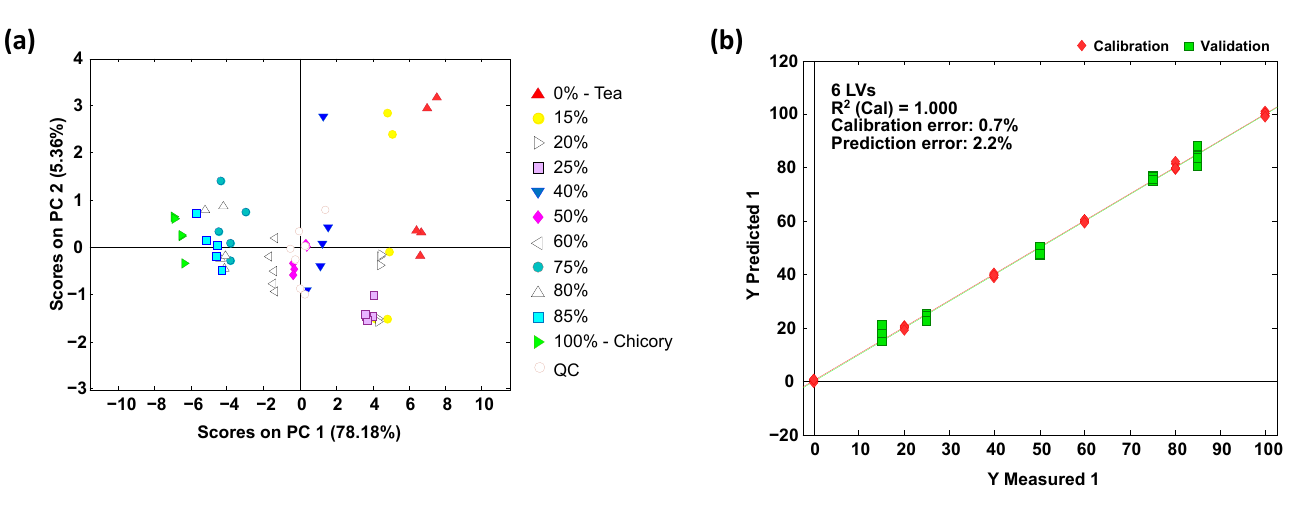
Figure 4. Green tea adulterated with chicory case. ( a ) PCA (PC1 vs. PC2) results showing the distribution of both calibration and prediction samples according to the chicory adulterant level. ( b ) PLS results showing the scatter plot of measured vs. predicted percentages of chicory adulterant. Table 2. Evaluation of the adulteration of tea with chicory by PLS using targeted HPLC-UV polyphenolic profiles as chemical descriptors.